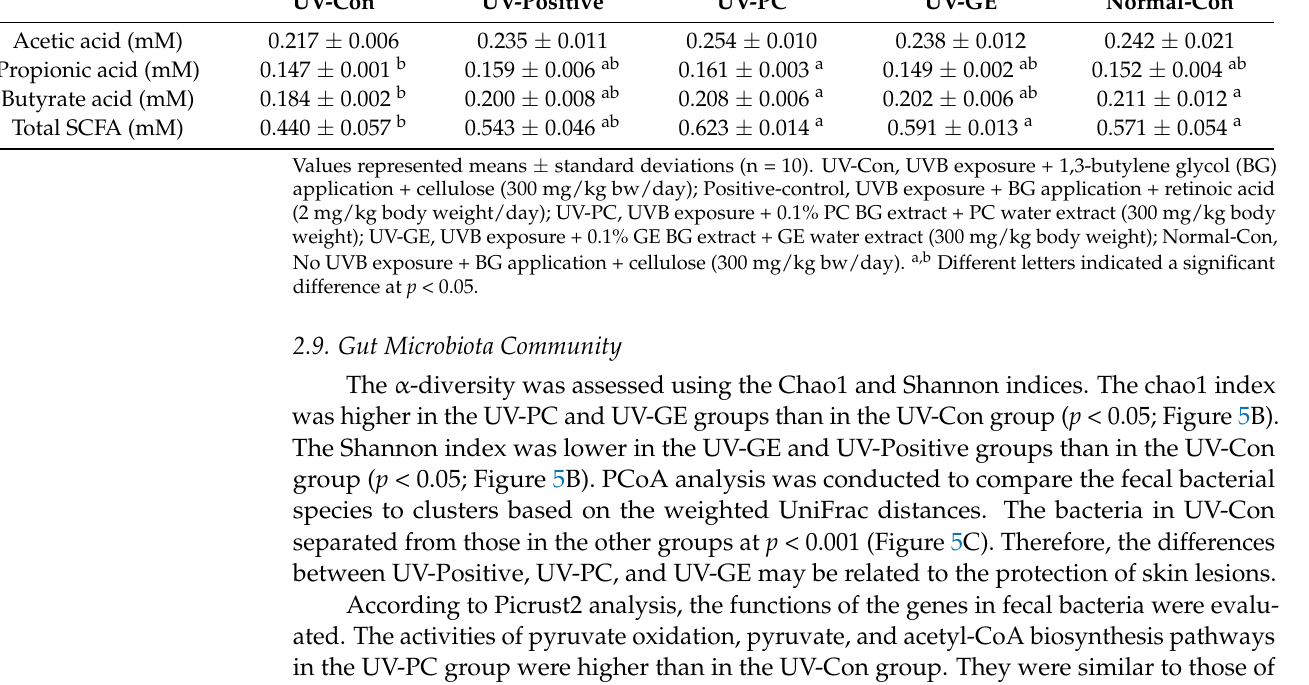
Table 3. Short-chain fatty acids (SCFA) concentration in serum from the portal vein. UV-Con UV-Positive UV-PC UV-GE